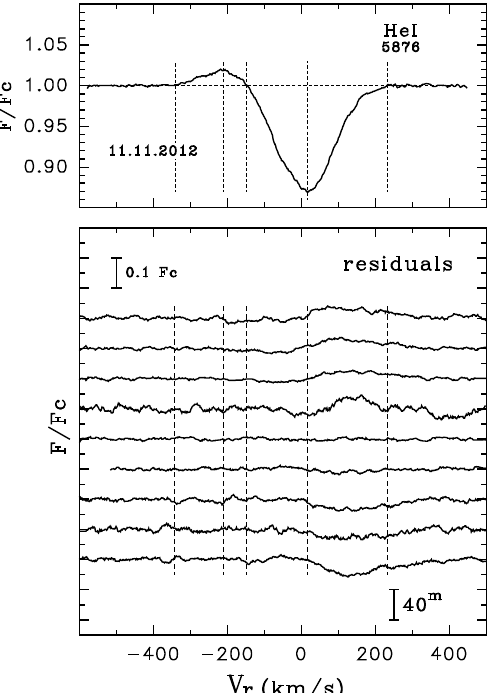
Figure 11. Top : Normalized profiles of the He I λ 5876 line observed in the spectrum of HD37806 on 11 November 2012. Bottom : Residual profiles constructed relative to the nightly mean. Both intensity and time scale are indicated. The time increases from top to